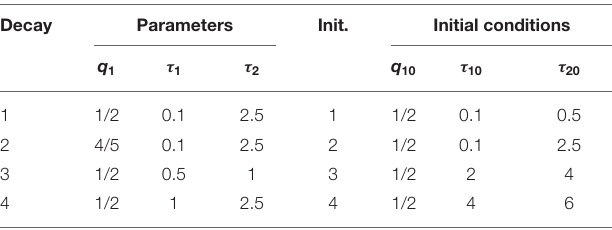
TABLE 2 | Bi-exponential decays and initial conditions for τ I and τ A estimations with LSM-2. Decay Parameters Init. Initial